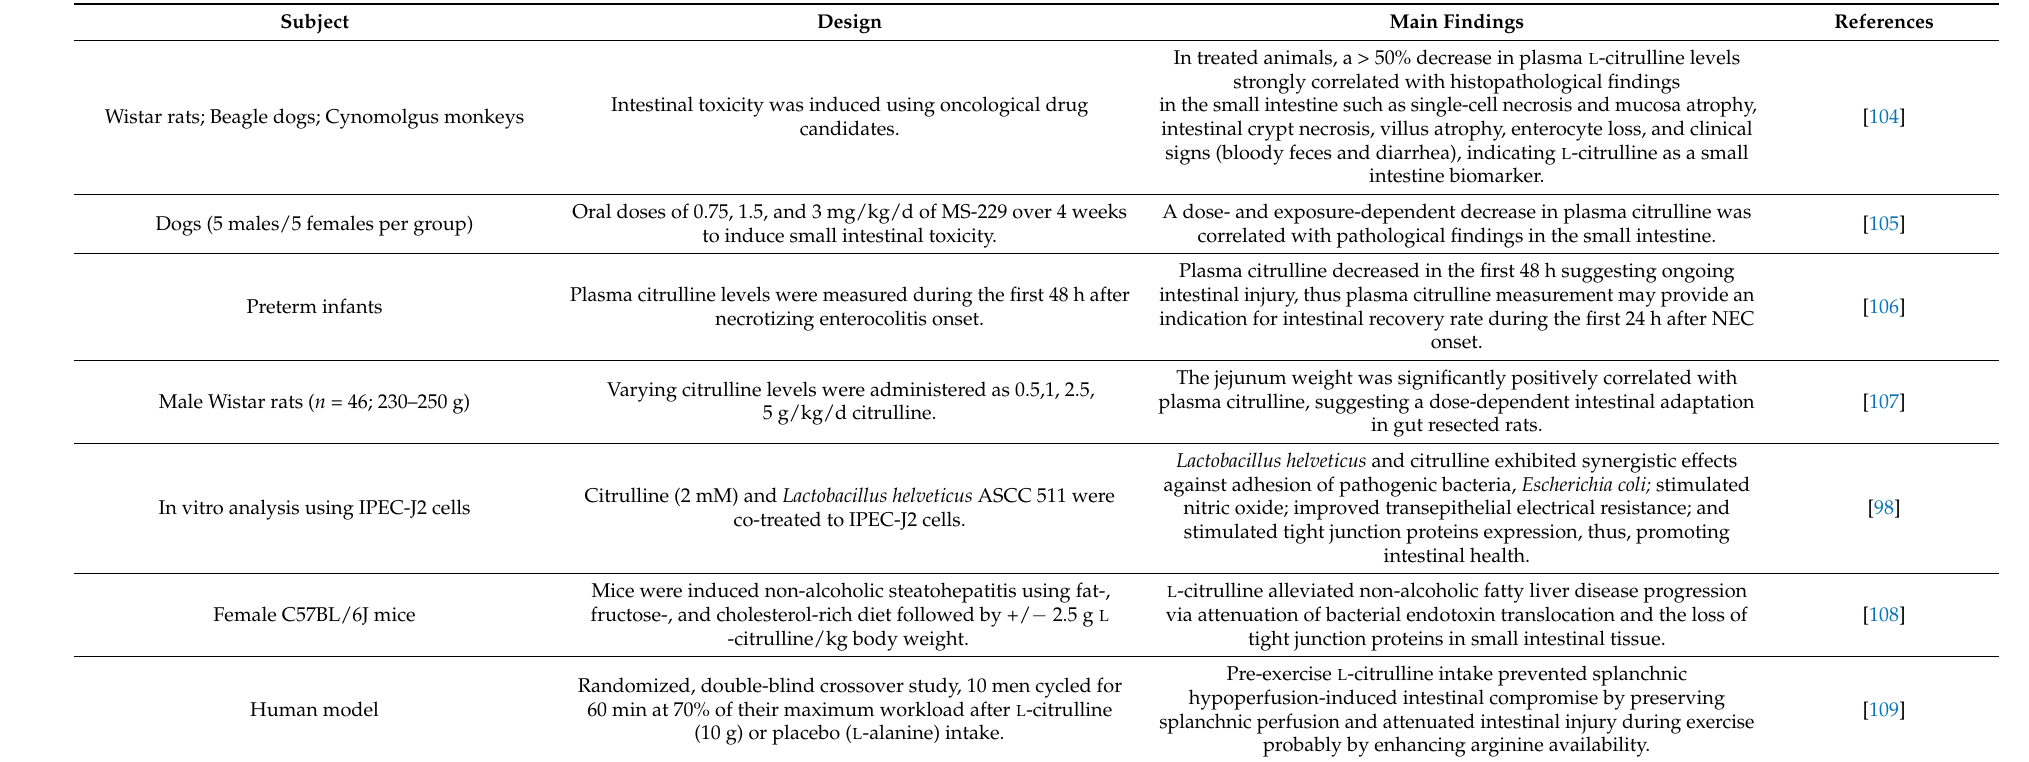
Table 1. Summarized roles of citrulline in promoting intestinal immune response and gut health in human and animal